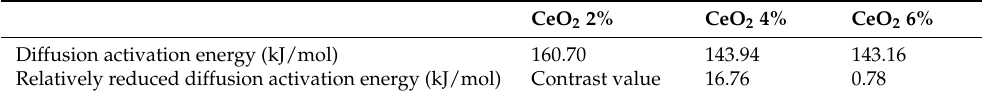
Table 8. Reduction of activation energy with different contents of rare earth CeO 2